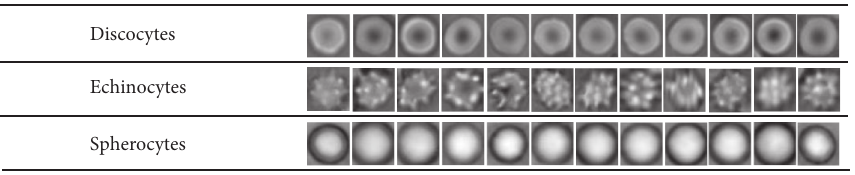
Figure 7: Examples of the three shapes of RBCs.